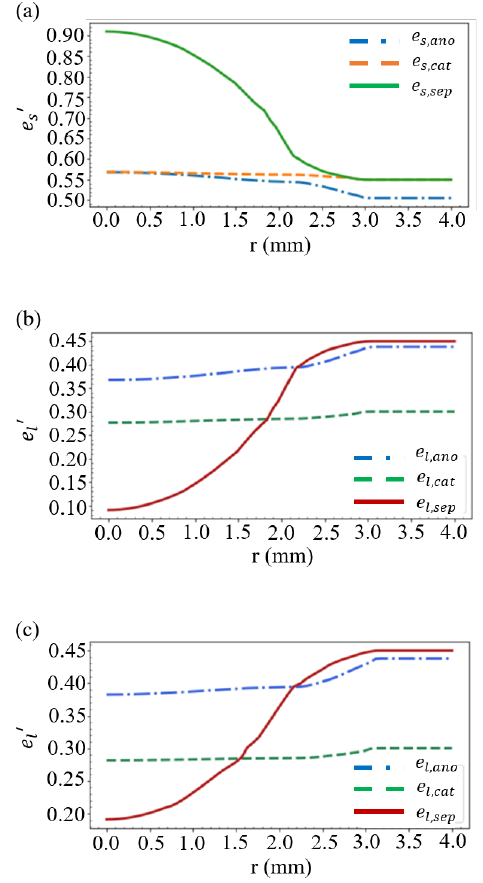
Figure 4. Distribution of the volume fractions of ( a ) the solid active material and ( b ) the electrolyte. ( c ) Volume fraction of the electrolyte when the separator thickness is increased from 13 to 23 μm.